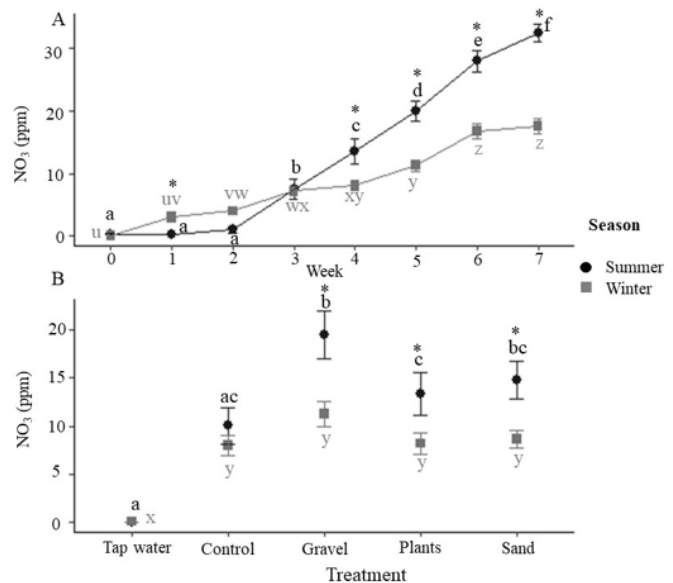
Figure 3. Tank concentrations of unionised ammonia. ( A ) Unionised ammonia (ppm) during sum- mer and winter for each week of the 7-week experimental period ( n = 20 tanks at each time point combined across treatments). Asterisks indicate significance between season within a time point and different letters indicate significance between weeks within the same season (post-hoc Tukey p < 0.05). ( B ) Unionised ammonia (ppm) by enrichment method with incoming tap water values also presented (tap water: n = 7; for control, gravel, plants, sand, n = 35 i.e., 5 tanks × 7 weeks with data combined across time). Asterisks indicate significance between seasons within a treatment (post-hoc Tukey p < 0.05). All data are means ± SEM.